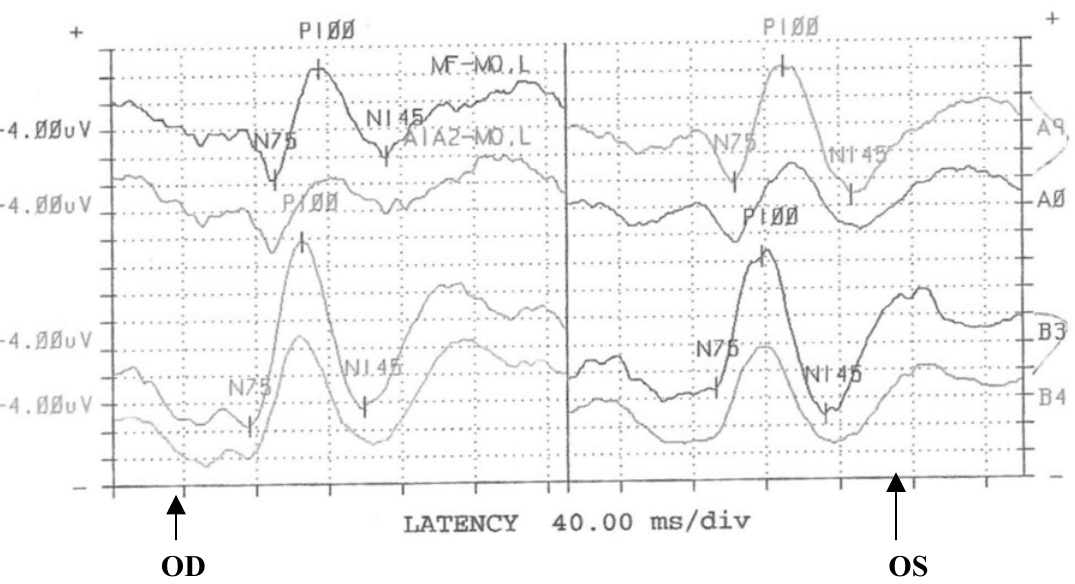
FIGURE 1. Pattern reversal VEPs in the left column are responses to 15’ checks and in the right column are responses to 31’ checks. The P100 is delayed with prolonged average latency of over 80 msec. Note the destructive effect of the disorder (retinopathy) on the N75. (As = 15’ checks; Bs = 31’